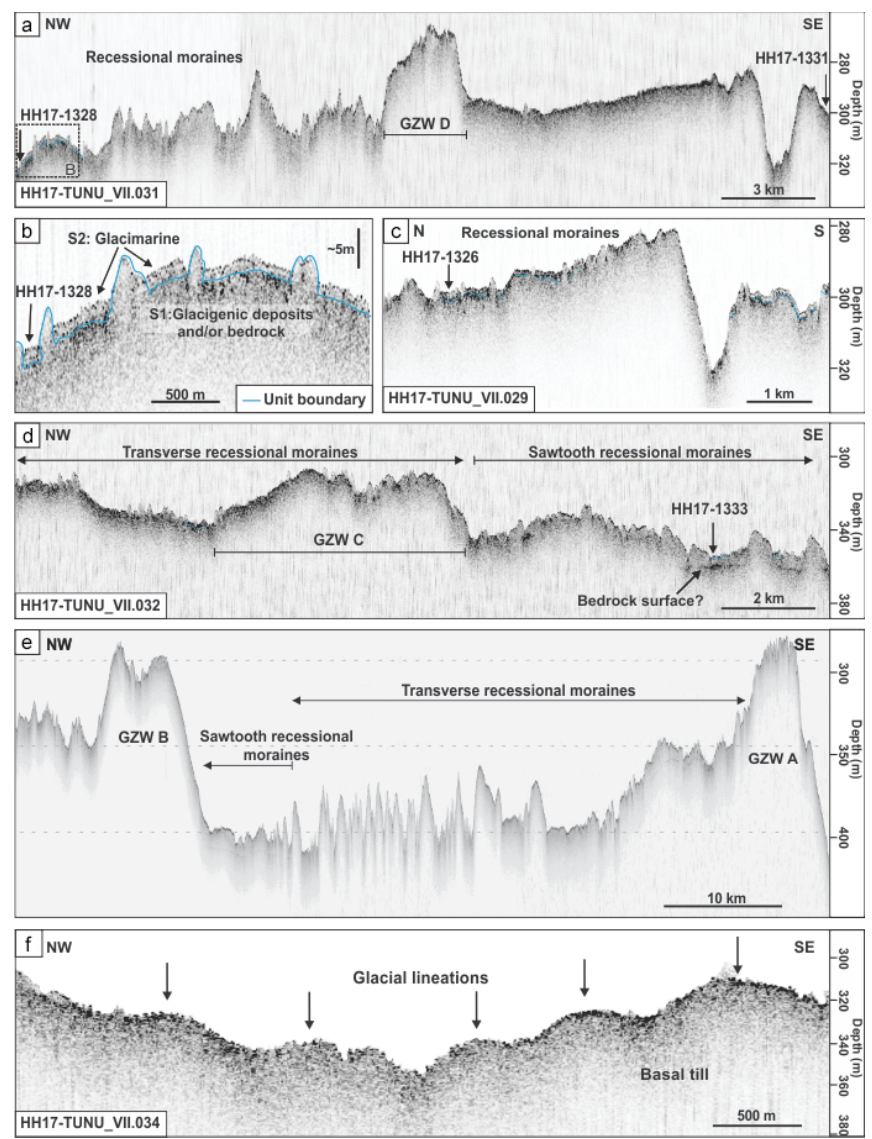
Figure 7. Chirp sub-bottom profiles from Store Koldewey Trough. See Fig. 1c for locations of (a) to (e) . (a) Chirp line HH17-TUNU_VII.031 across grounding zone wedge D and recessional moraines from the middle trough area. Projected positions of sediment cores HH17-1328 and HH17-1331 are shown. Black dotted rectangle shows extent of the profile in panel (b) . (b) Part of chirp line HH17-TUNU_VII.031 showing a close-up example of the configuration of units S1 and S2. (c) Chirp line HH17-TUNU_VII.029 from the inner part of the trough, with recessional moraines. Projected position of sediment core HH17-1326 is indicated. (d) Chirp line HH17-TUNU_VII.032 across grounding zone wedge C. The locations for transverse recessional moraines, sawtooth recessional moraines and sediment core HH17-1333 are indicated. (e) Chirp line across grounding zone wedge A and B, separated by sawtooth and transverse recessional moraines. Modified from Laberg et al. (2017). (f) Part of chirp sub-bottom profile HH17-TUNU_VII.034 showing the acoustically transparent deposits interpreted as basal till/glacial lineations. The ridges of the latter are indicated with arrows. For location, see Fig.